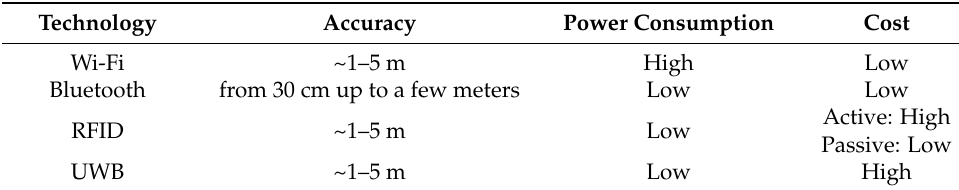
Table 1. Overview on indoor localization